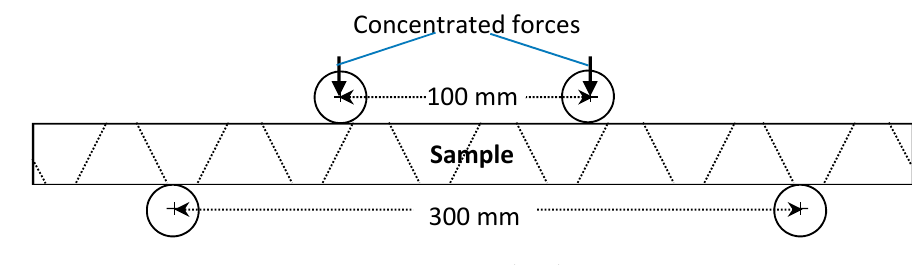
Figure 4. Four-point bending test.